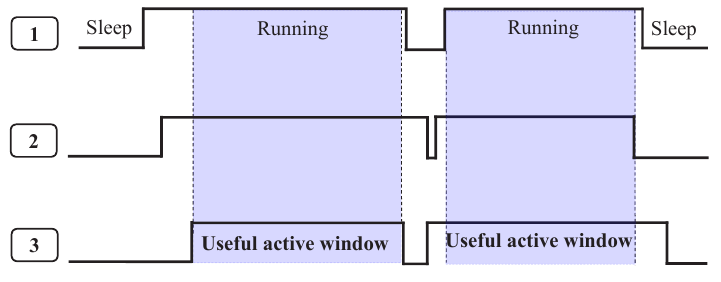
Figure 3. Synchronization activity and useful active